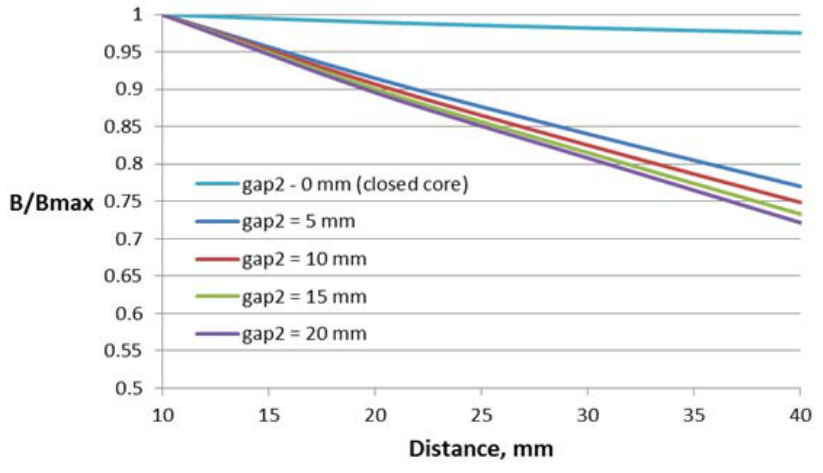
Figure 13. Dependence of the flux density on the distance to the conductor for the concentrator with two gaps and different values of the second air gap (gap2).